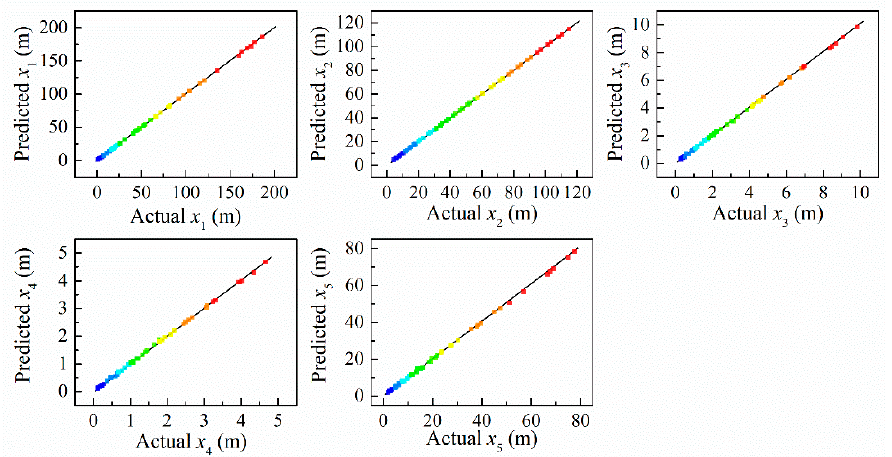
Figure 16. Scatter diagram of the displacement responses.